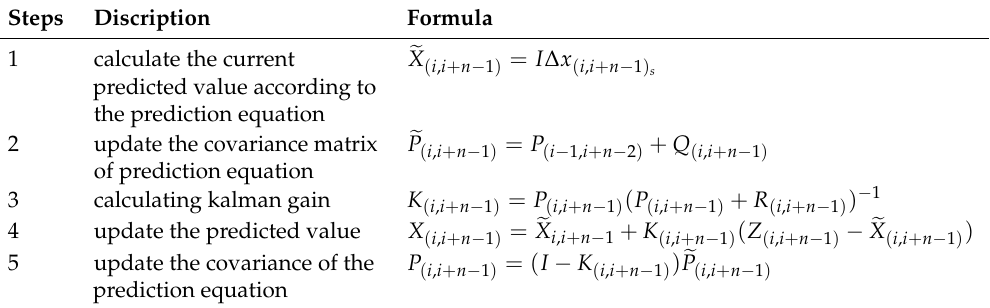
Table 1. Trajectory obtained by our method in the second